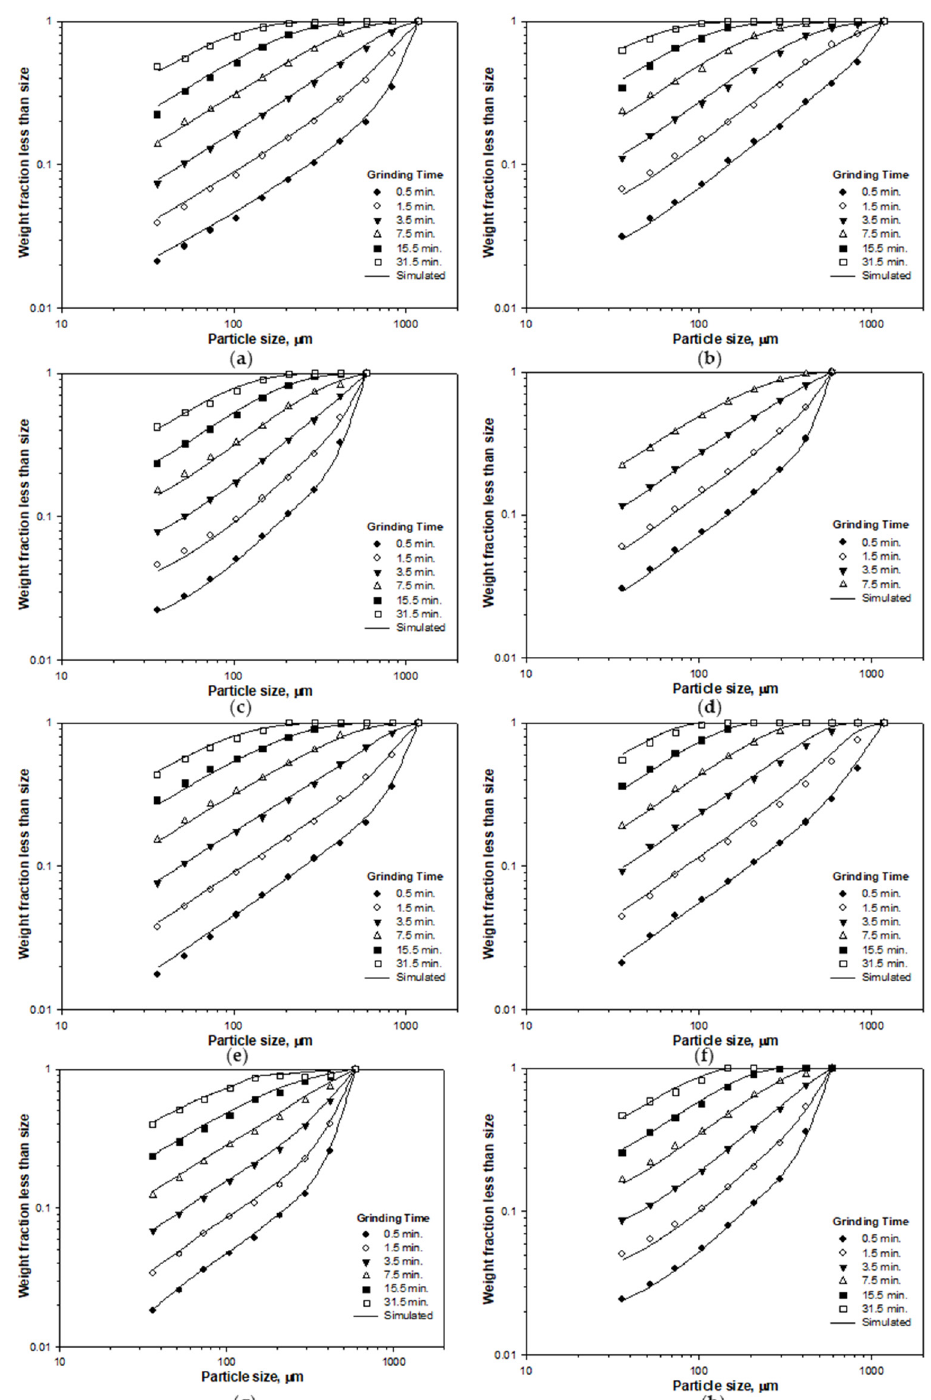
Figure 5. Comparison between simulated and experimental size distributions obtained in the grinding tests: ( a ) Uranium (dry), 1180 × 830 μ m; ( b ) uranium (wet), 1180 × 830 μ m; ( c ) uranium (dry), 590 × 420 μ m; ( d ) uranium (wet); 590 × 420 μ m, ( e ) molybdenum (dry), 1180 × 830 μ m; ( f ) molybdenum (wet), 1180 × 830 μ m; ( g ) molybdenum (dry), 590 × 420 μ m; ( h ) molybdenum (wet), 590 × 420 μ m. ( f ) molybdenum (wet), 1180 × 830 µ m; ( g ) molybdenum (dry), 590 × 420 µ m; ( h ) molybdenum